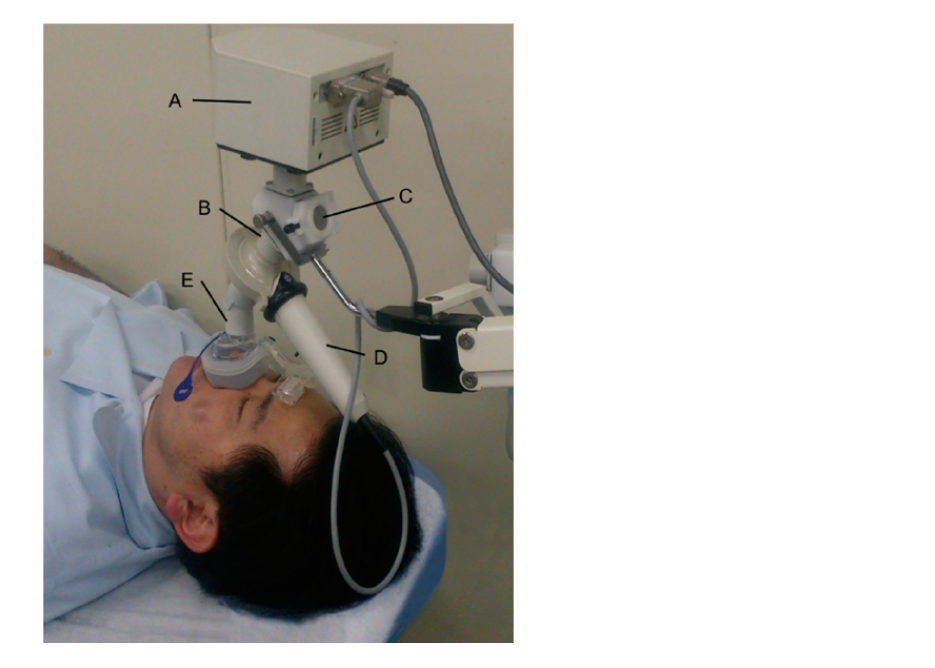
Figure 1. Impulse oscillometry system used in this study: loudspeaker ( A ), screen flap ( B ), Y-adapter ( C ), pnuemochomatograph ( D ), nasal mask ( E ).